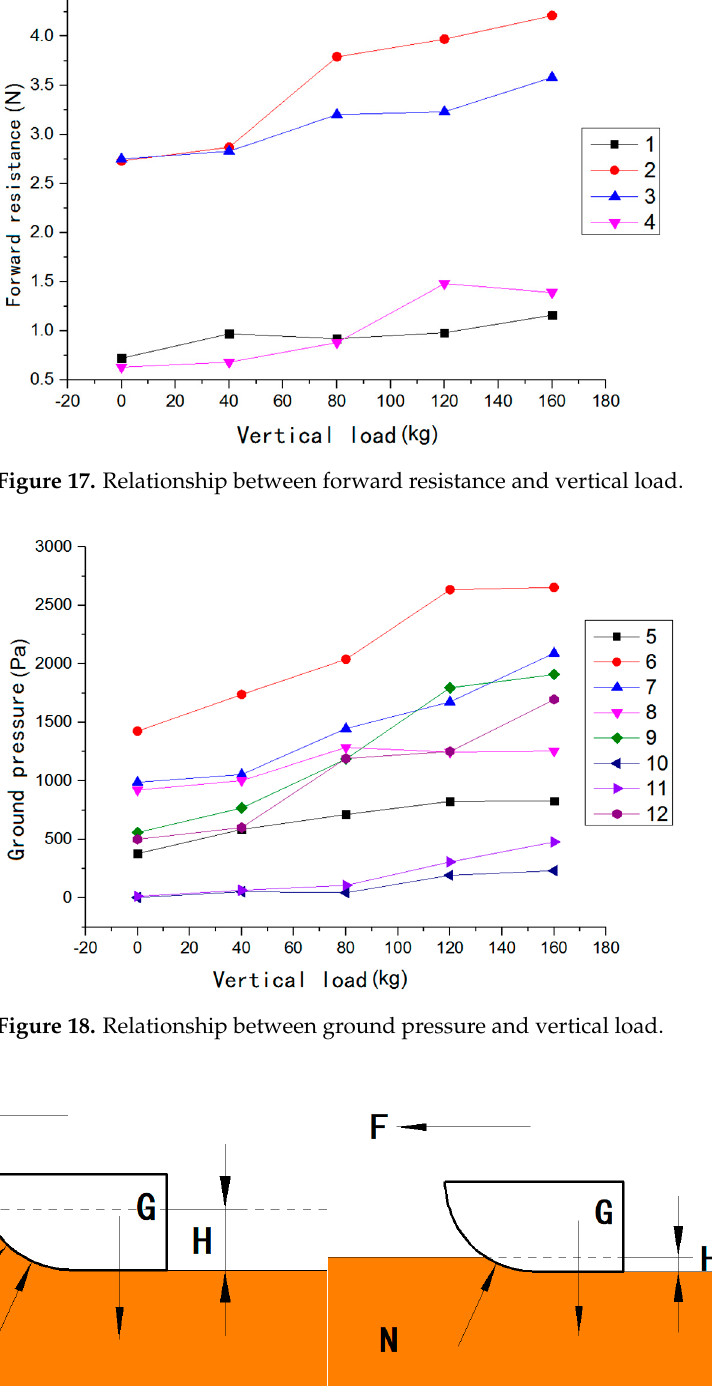
Figure 19. Force analysis of the skateboard under different accumulation thicknesses (H) of mud.